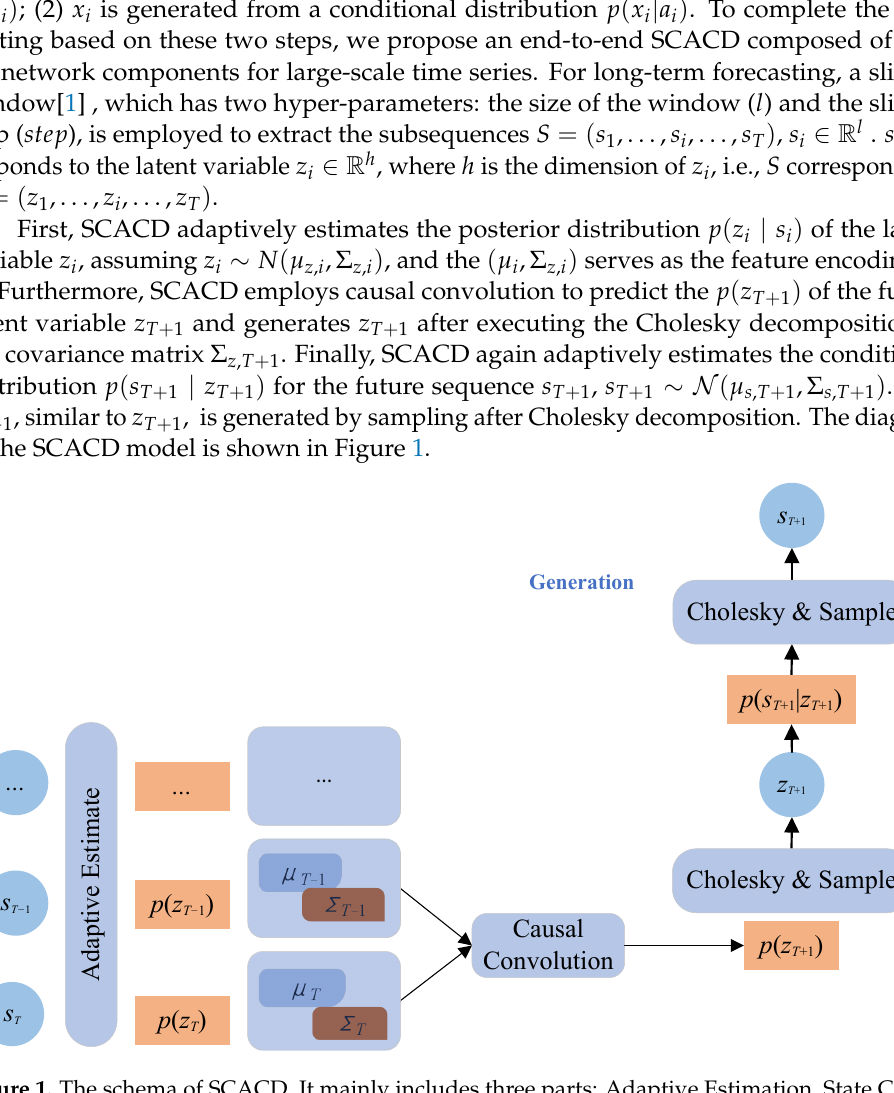
Figure 1. The schema of SCACD. It mainly includes three parts: Adaptive Estimation, State Causal Convolution, and Cholesky